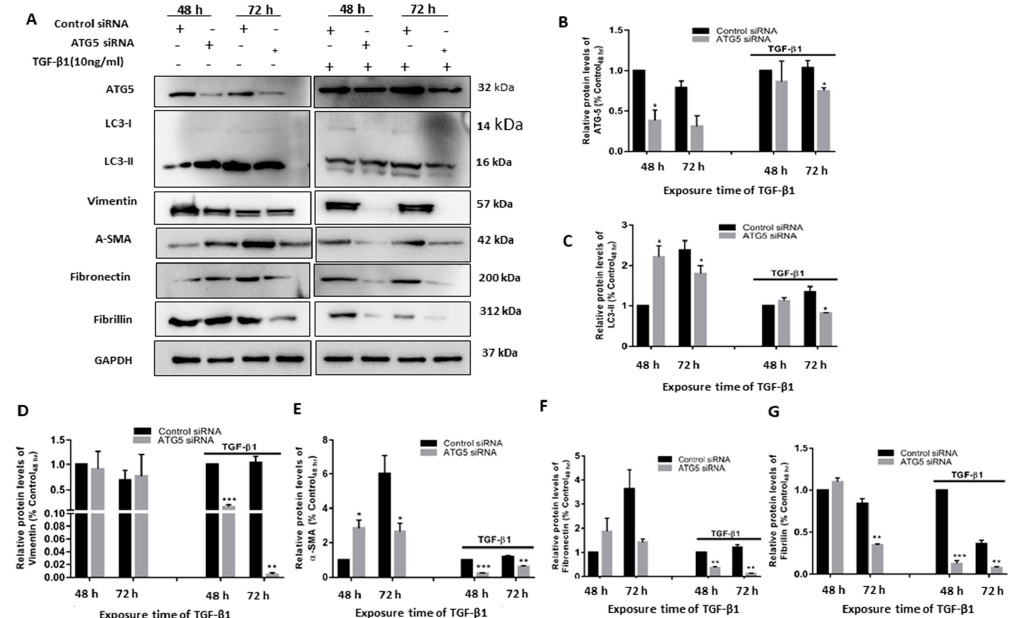
Figure 2. TGF-induced fibrosis and EMT is regulated by ATG5. ( A ) The protein levels of ATG-5, LC3-I, LC3-II, SMA, vimentin, fibronectin, and fibrillin in whole-cell lysates of siRNA-mediated knockdown HTM cells with (10 ng/mL) and without TGF- β 1. ( B – G ), relative quantification of the proteins obtained using densitometry analysis of the bands. The error bars represent the standard deviation (*— p < 0.05, **— p < 0.01, ***— p < 0.001, by t -test).